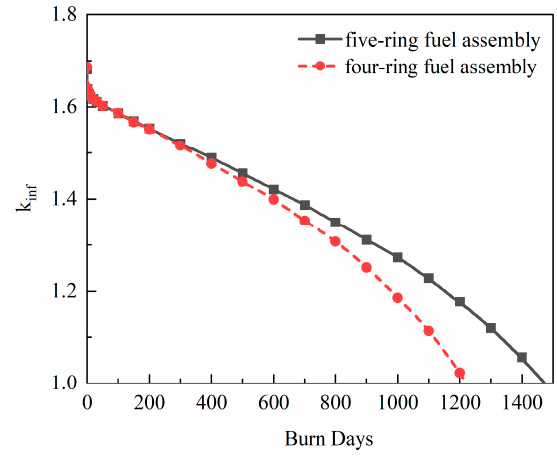
Figure 3. k inf curves of different fuel assembly designs.